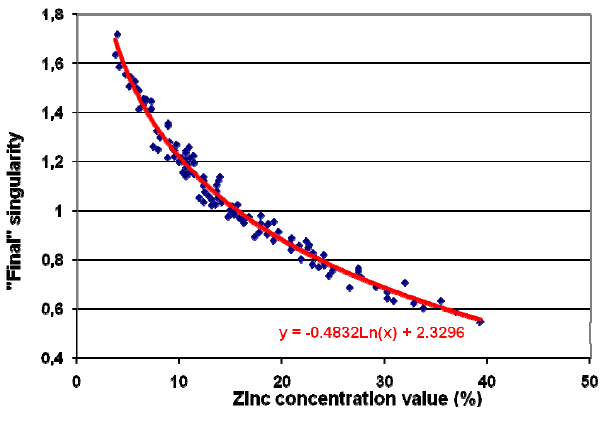
Fig. 21. Relationship between final singularity and zinc concentration value is logarithmic. Final singularities (blue diamonds) are same as those for Series 3 in Fig. 20. Logarithmic curve (red line) was fitted by least squares.